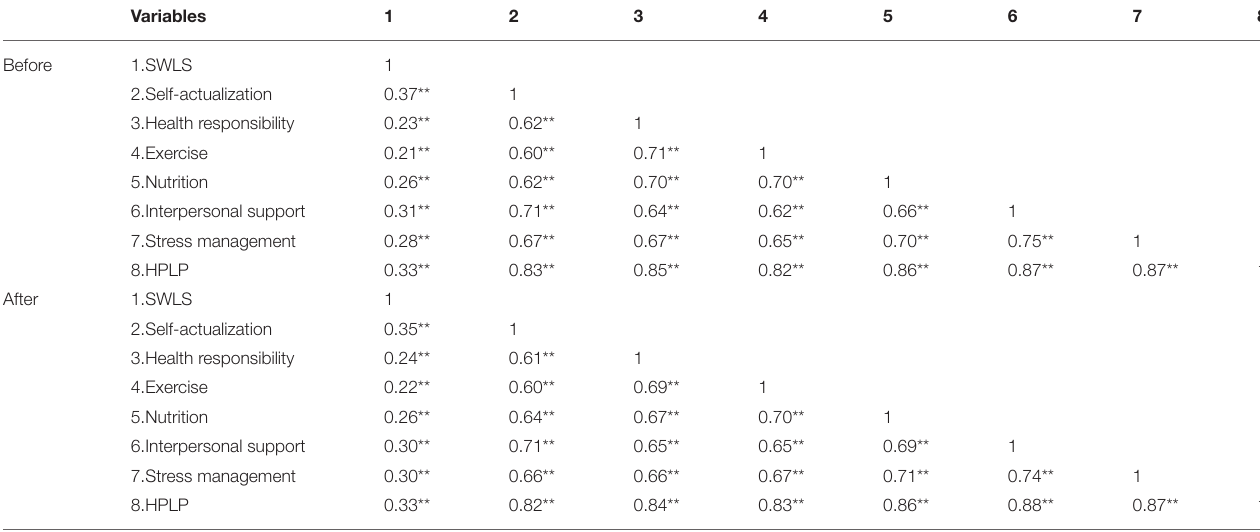
TABLE 4 | Correlations between health-promoting lifestyle and life satisfaction ( N = 2,054). Variables 1 2